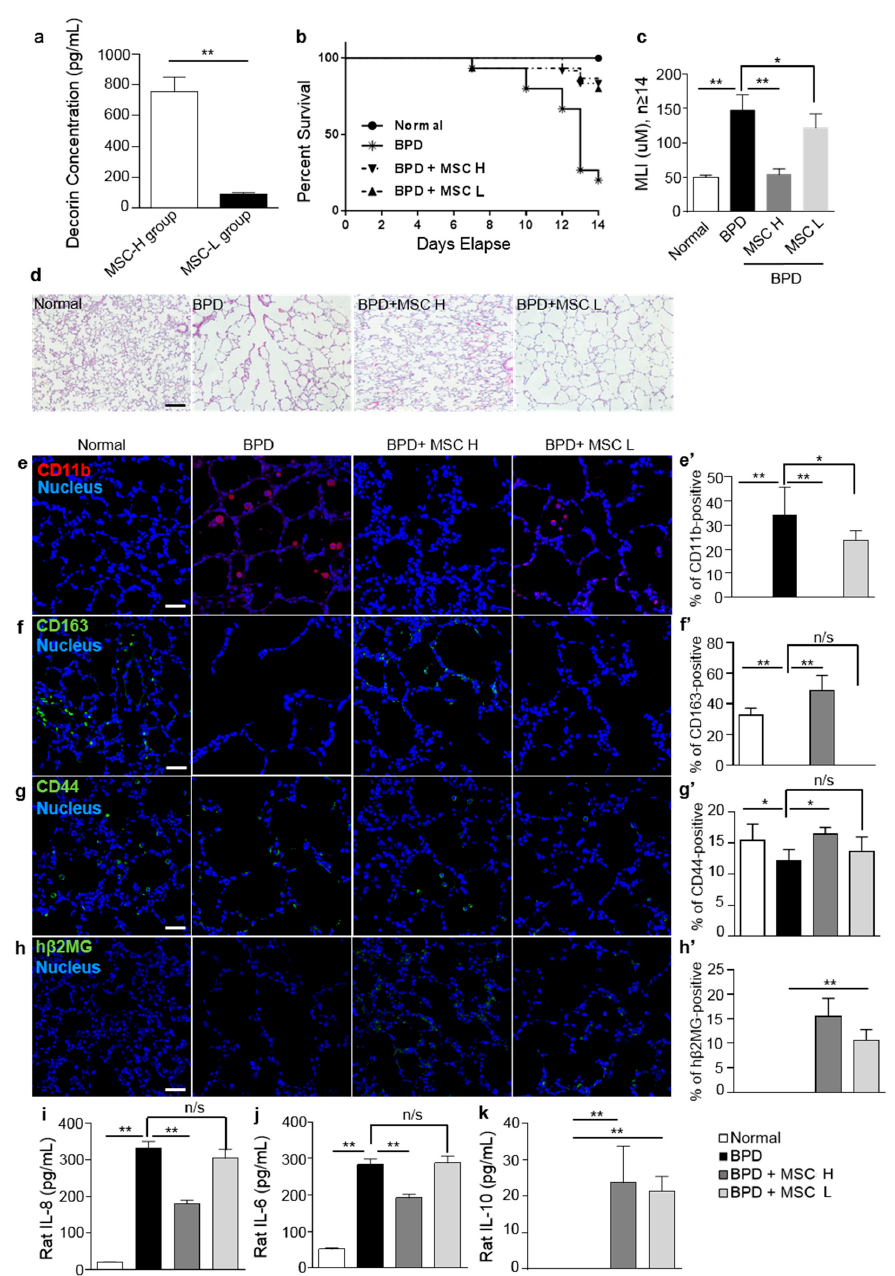
Figure 4. MSCs promote tissue repair in a hyperoxic lung injury rat model. The normal group was raised under normoxic conditions, whereas the experimental groups (bronchopulmonary dysplasia (BPD), BPD + MSC H, or MSC L) were raised under hyperoxia conditions (90% oxygen) from 10 h after birth to postnatal day (P14). On day 5, 1 × 10 5 MSCs were injected intratracheally. Rat pups were sacrificed and lung tissues and bronchoalveolar lavage fluid (BALF) samples were collected on P14. ( a ) MSCs were divided into two groups (MSC-H and MSC-L) according to their decorin expression levels. Decorin secretion by MSCs was quantified by secretome analysis and ELISA. Supernatants from co-cultures of macrophages and MSCs showed different levels of decorin. ( b ) MSC H lot was selected from MSC-H groups and MSC L lot was selected from MSC-L groups. Kaplan–Meier survival curve at birth and P14. ( c ) Morphometric analysis of lung tissues was performed to determine the